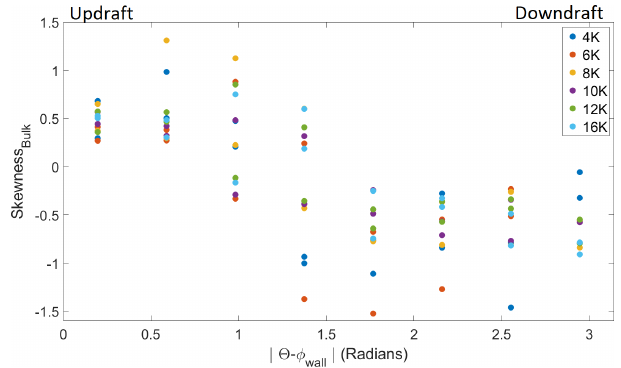
Figure 11. The skewness of the temperature measurements as a function of the angular distance from the updraft. The temperature was filtered using a high-pass Fourier filter with the cutoff at around 5min. Near the updraft, the temperature fluctuations are positively skewed. Near the downdraft, the temperature fluctuations are nega- tively skewed. (cid:49)T does not change the value of the skewness.